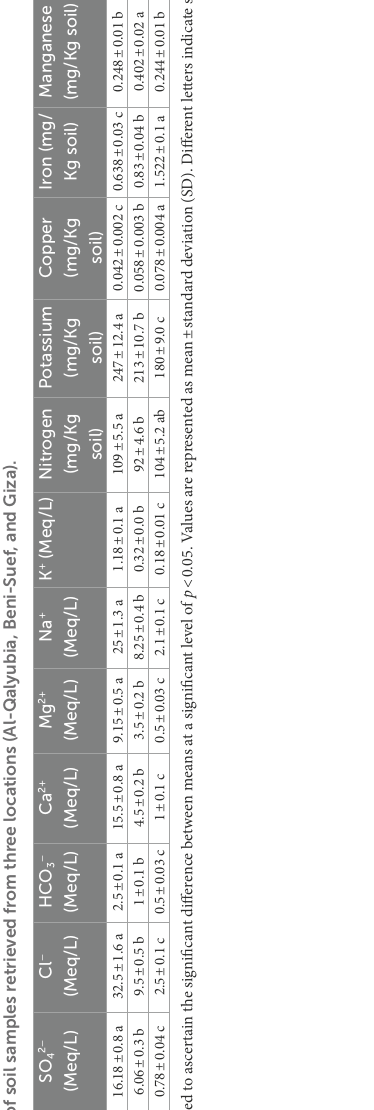
FIGURE 4 Characterization of the most dominant bacterial phyla in soil from three locations (Q, B, and G) using 16S rRNA next- generation sequencing (NGS) and qPCR. Each bar represents the mean percentage ± standard deviation (SD; n = 3). G; Giza location, Q; Al-Qalyubia location, and B; Beni-Suef location.